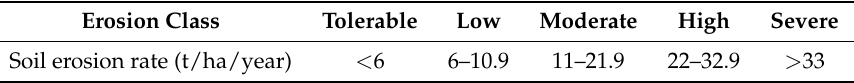
Table 4. Soil erosion risk categories defined by OECD